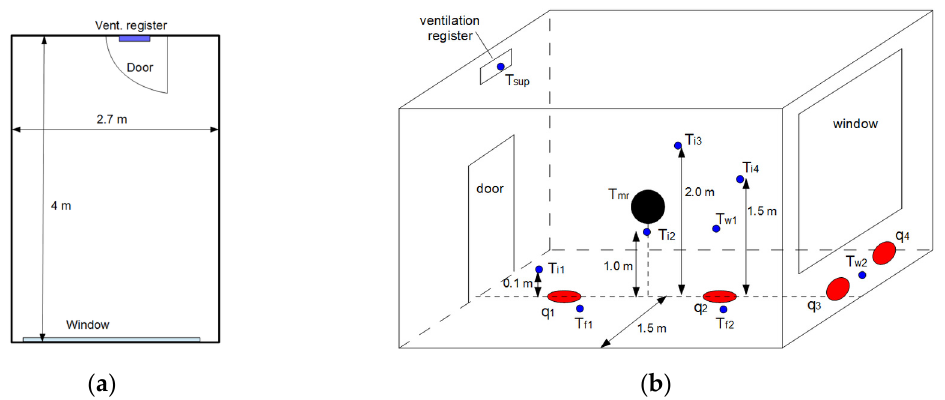
Figure 2. The test room: ( a ) View of the room selected for experiment; ( b ) Schematic location of sensors in the room.